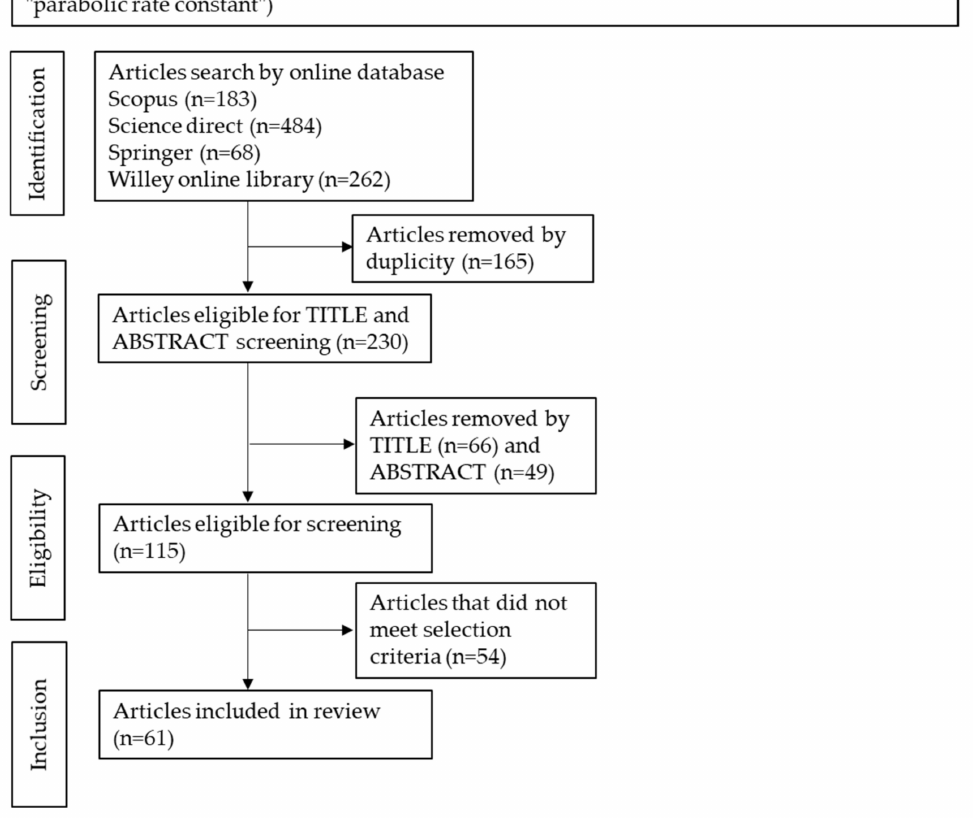
Figure 1. Search strategy used to identify eligible articles for